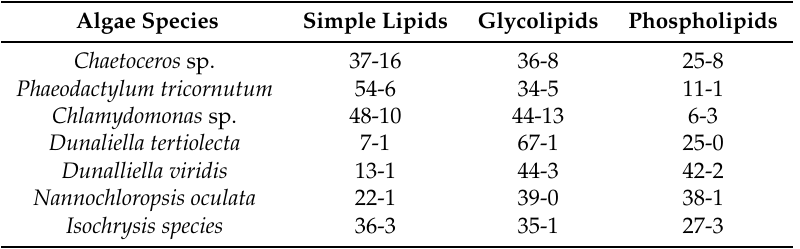
Table 3. Mean lipid content as a percentage of total lipids